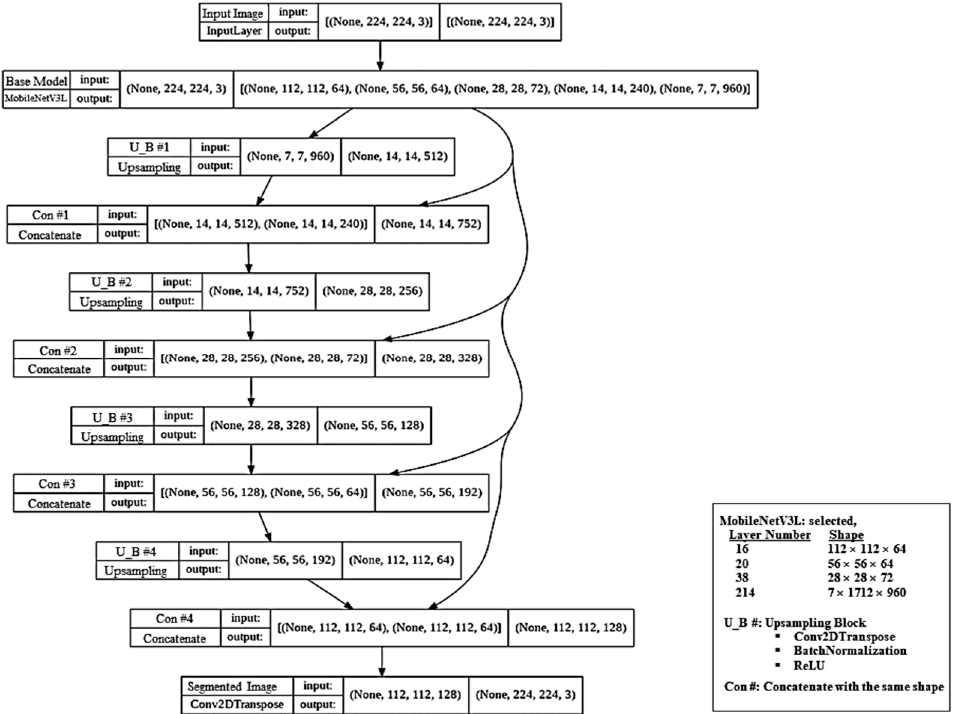
Figure 10. Illustration of the proposed MobileUNetV3 deep-learning model in the form of a concept map.